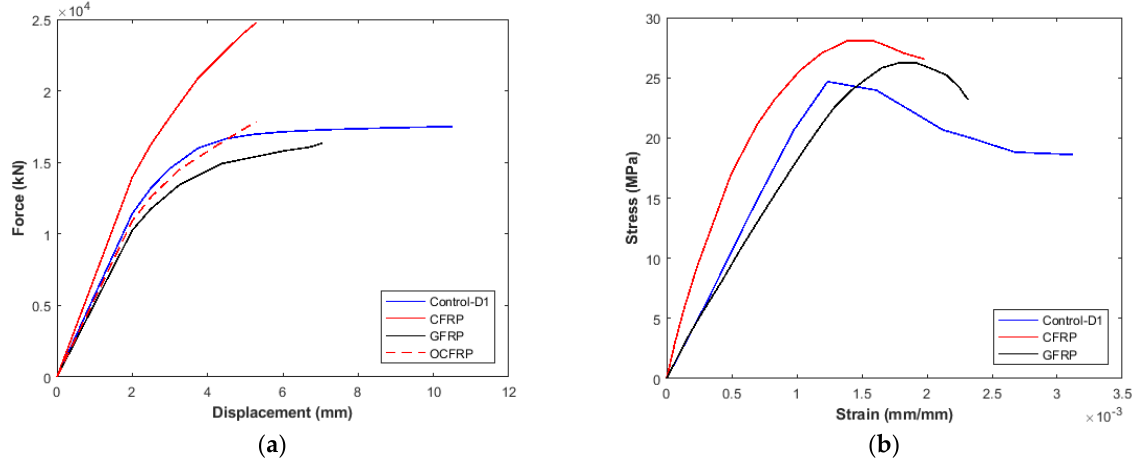
Figure 10. Group D ( a ) Load-Displacement diagram ( b ) Stress-Strain Diagram.